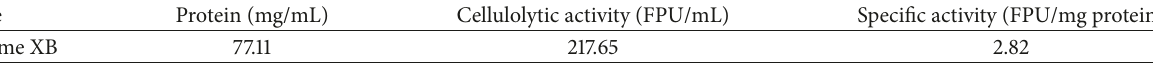
Table 3: Enzymatic activity of the enzyme cocktail Celluzyme XB.